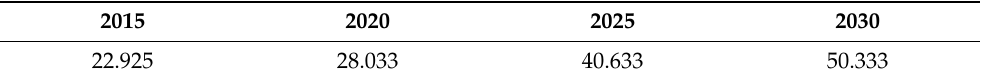
Table 1. Spanish wind installed capacity in the objective scenario (GW).